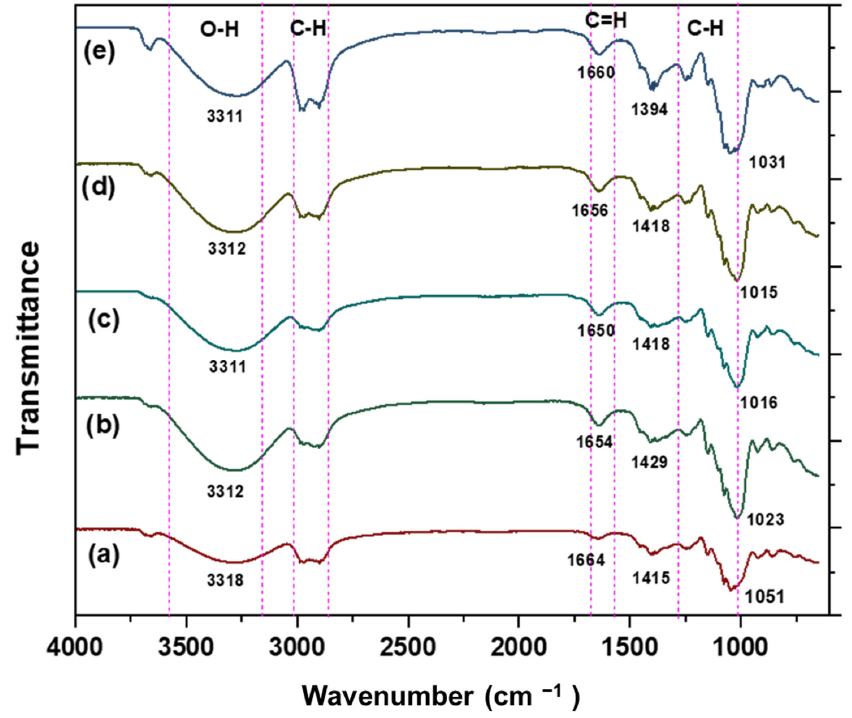
Figure 4. FTIR spectra of starch films and anthocyanin incorporated in starch films, ( a ) ( b ) 8% RCA film, ( c ) 10% RCA film, ( d ) 12% RCA film and ( e ) 14% RCA control film, ( b ) 8% RCA film, ( c ) 10% RCA film, ( d ) 12% RCA film and ( e ) 14% RCA film.